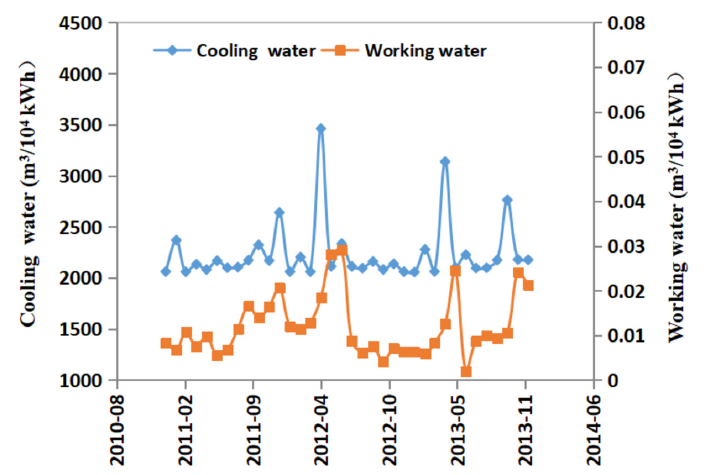
Figure 9. Water consumption for electricity generation per month at the Dayawan nuclear power plant from January 2011 to December 2013.